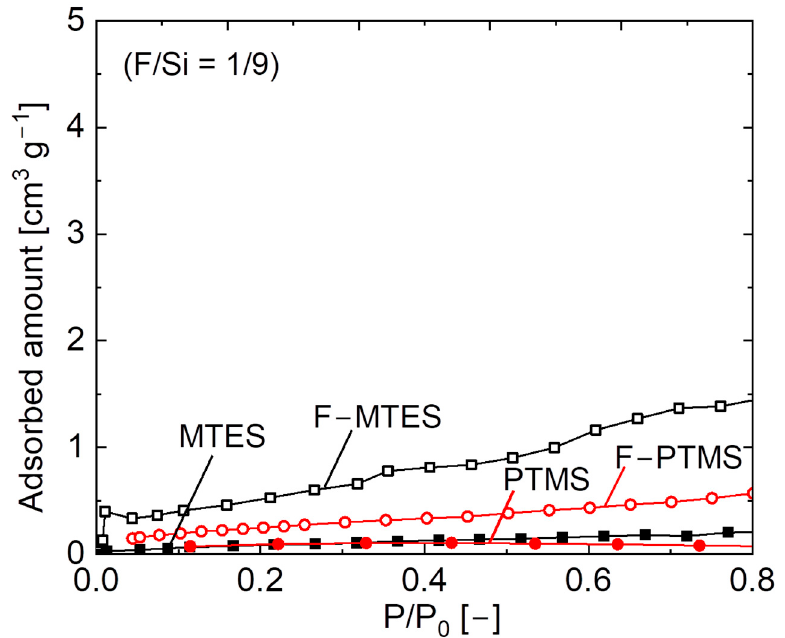
Figure 7. N 2 adsorption isotherms of fluorine–doped (F–MTES, F–PTMS) and undoped (MTES, PTMS) pendant–type organosilica gels calcined at 300 °C under a N 2 atmosphere.